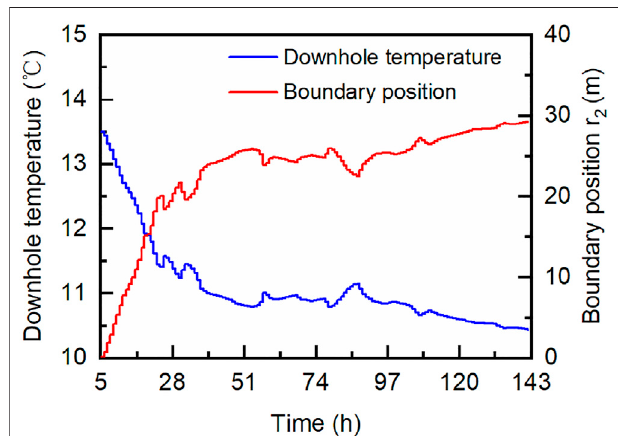
FIGURE 4 | Downhole temperature of the production well and corresponding extrapolated position of the lateral heat conduction boundary.